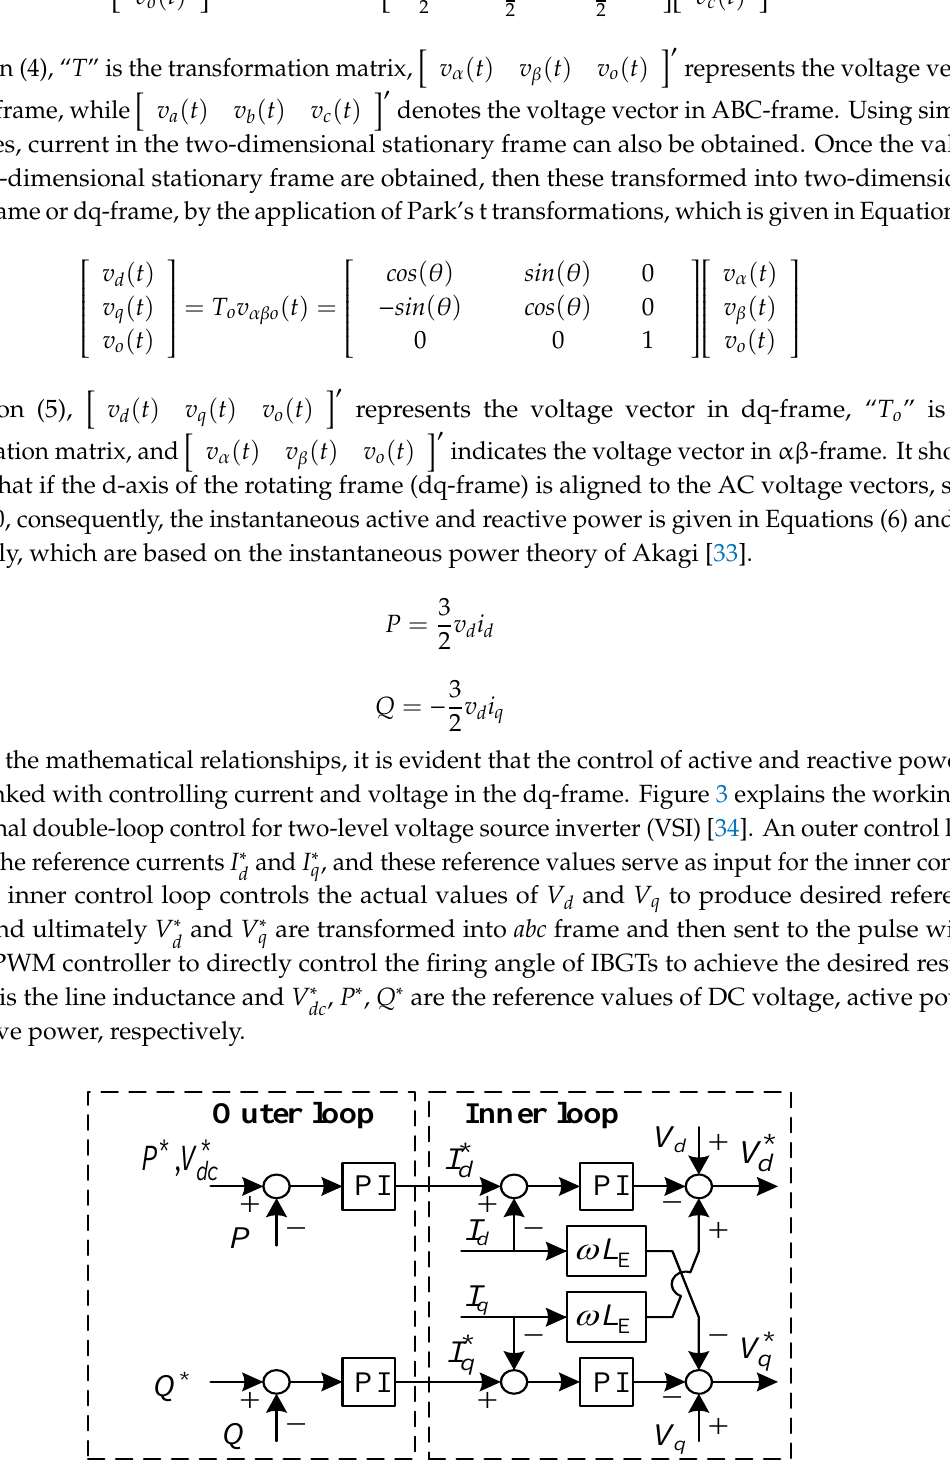
Figure 3. Double loop-control for the converter.